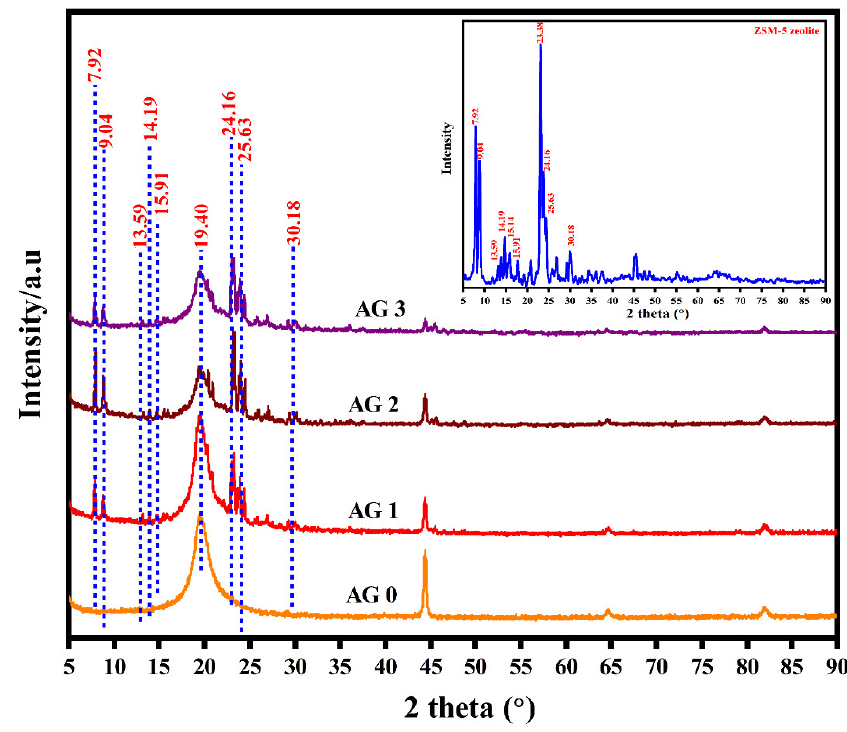
Figure 2. X-ray diffraction (XRD) patterns of zeolite-incorporated agar/cellulose/PVA biomembrane and corresponding ZSM-5 zeolite (inset).